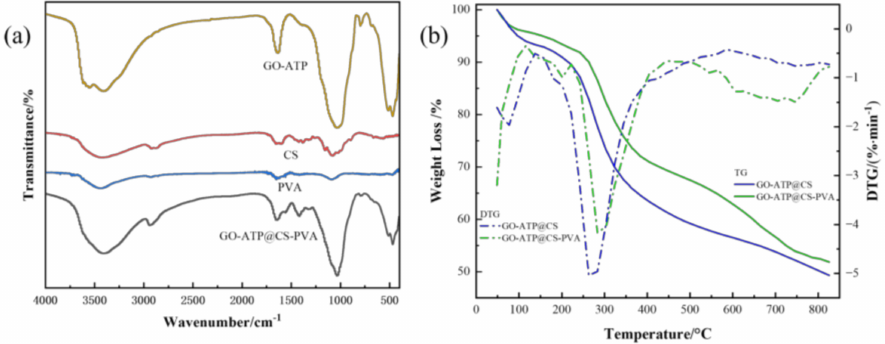
Figure 4. ( a ) FT − IR spectra of GO − ATP, CS, PVA and GATP@CS − PVA composites; ( b ) The TG/DTG curves of GO − ATP@CS and GO − ATP@CS −